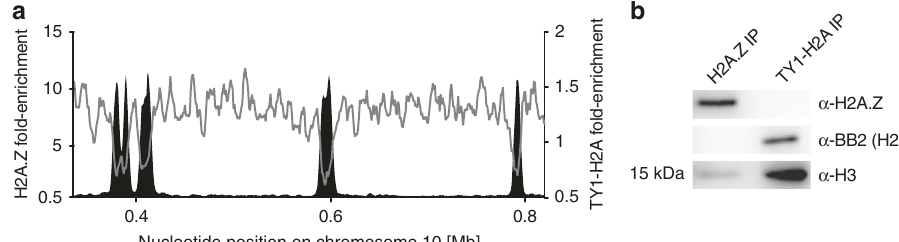
Fig. 1 H2A.Z replaces H2A at TSSs. a MNase-ChIP-seq data of the histone variant H2A.Z (black; n = 1) and of the overexpressed and TY1-tagged canonical histone H2A (gray; n = 2) are shown across a representative region of chromosome 10. The ChIP-seq data are normalized to input data. b Western blot of proteins co-immunoprecipitated with H2A.Z (left lane) or TY1-H2A (right lane). Mononucleosomes were extracted from a cell line, which allows the inducible overexpression of ectopic TY1-H2A, and were immunoprecipitated using either a custom-made antibody against untagged H2A.Z ( n = 1) or the BB2 antibody recognizing TY1-tagged H2A ( n = 1). Immunoprecipitated material was then examined by western blotting for the presence of TY1-H2A or untagged H2A.Z along with histone H3 as loading control. Source data are provided as a Source Data fi